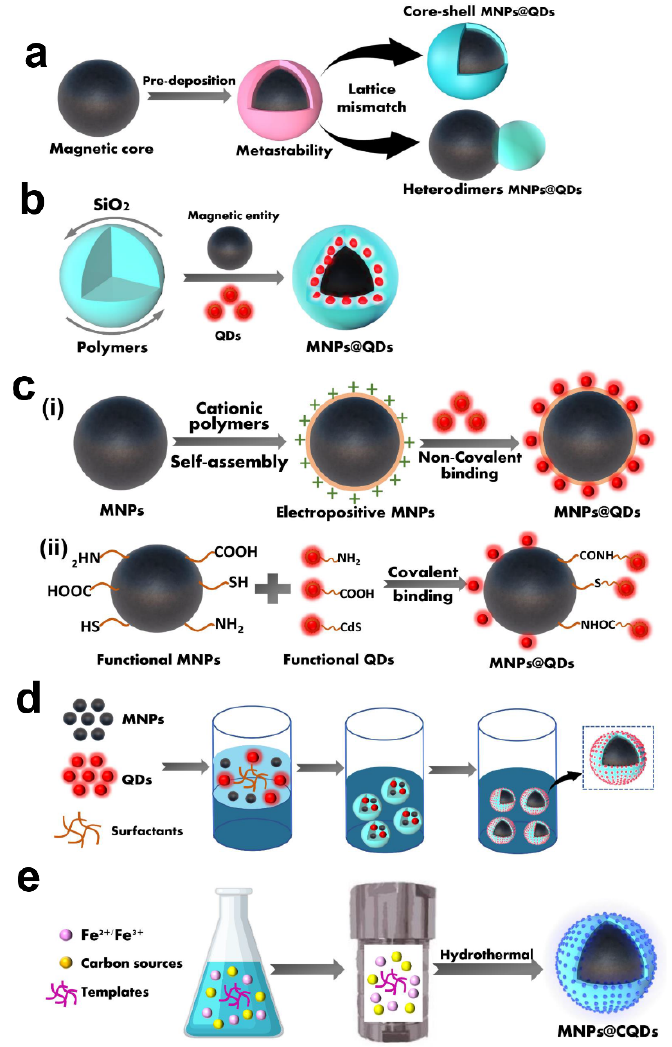
Figure 3. Schematic diagram of five preparation methods of MNPs@QDs nanocomposites. ( a ) Hetero-crystalline growth; ( b ) Template embedding; ( c ) Layer-by-layer assembly constitute of ( i ) non-covalent binding and ( ii ) covalent binding; ( d ) Microemulsion technique; ( e ) One-pot method.